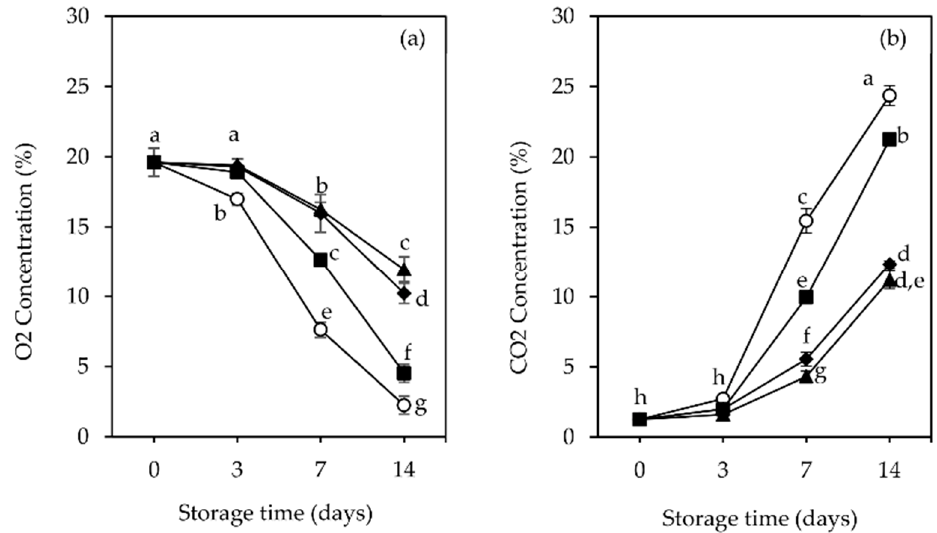
Figure 1. Changes in headspace gas composition: ( a ) O 2 and ( b ) CO 2 concentrations (%), of raspberry ( Rubus idaeus L. cv. ‘Kweli’) fruit packages (no film-pad_Ctr, ○ ; with film-pad containing green tea extract_Ch + GTE, ◆ , rosemary extract_Ch + RSME ▲ , only chitosan ■ ), stored for 14 days at 4 °C under passive MAP conditions. Vertical bars indicate standard deviation of five replicates. Means with equal letters are not statistically different by Tukey’s test with 5% significance level.